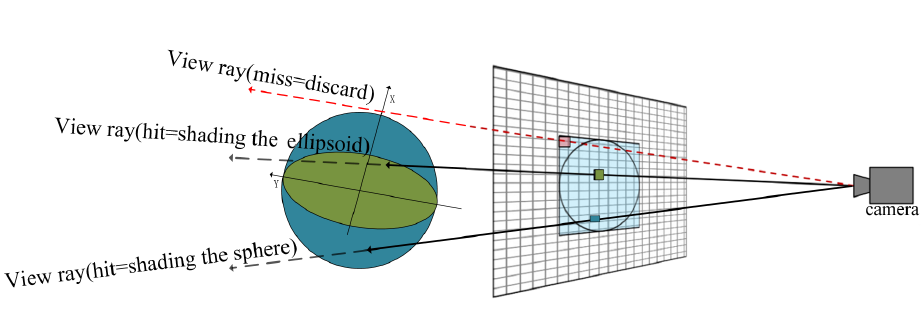
Figure 9. glyph ray casting rendering of sphere and ellipsoid based on graphics processing unit (GPU)